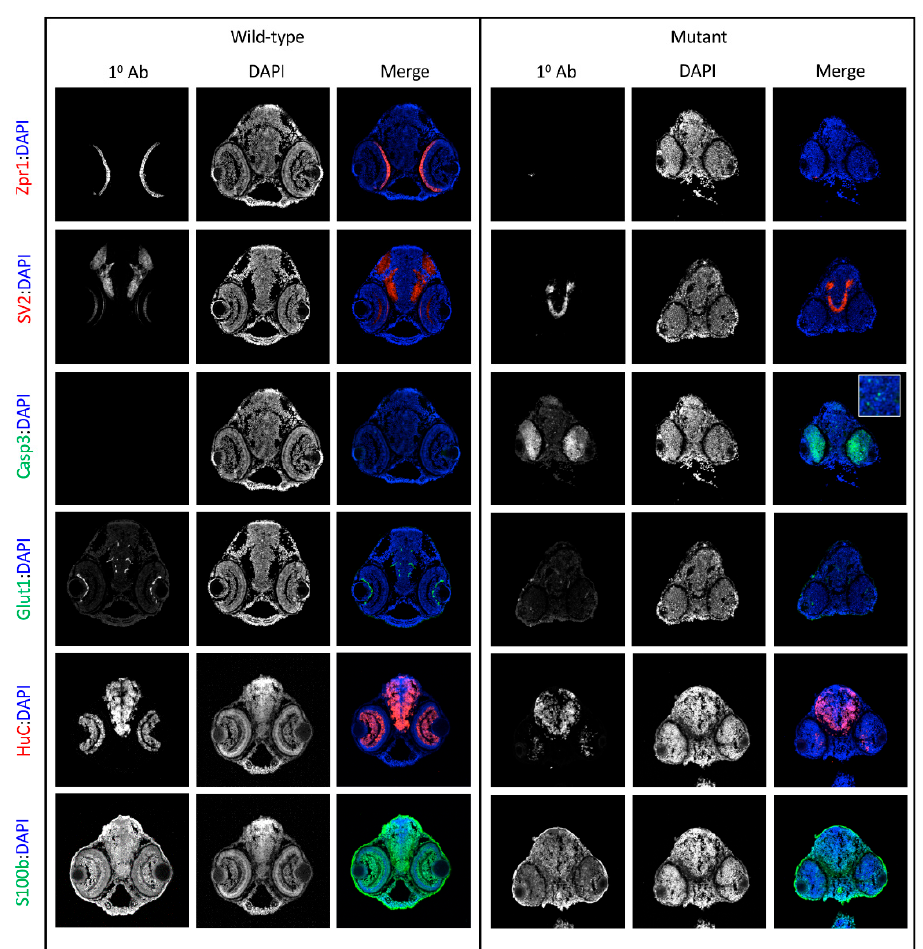
Figure 5. IHC characterizes cp27.5 mutants. IHC identifies additional abnormalities in protein expression in cp27.5 mutants at 3 dpf. All sections are counterstained with DAPI (blue) (middle columns for wild-type and mutant). Row 1 : Zpr1 (red) labels photoreceptors in the retina which are present in wildtype, but not in mutant. Row 2 : SV2 labels synaptic vesicles within the brain and within the inner plexiform layer of the retina in wild-type. SV2 is present in the brain, but absent in the retina in mutants. Row 3 : Caspase 3 is not expressed in wild-type, but is prominent in the eyes in mutants. Mutant brains also contain punctate Caspase 3 expression (inset). Row 4 : Glut1 is noticeably expressed in brain and eye vasculature in wild-type, but mutants have faint Glut1 expression in brain vasculature and eye. Row 5 : HuC is expressed in neurons throughout the brain and eye in wild-type. HuC is expressed in the brain in mutants; however, it is not as organized as wild-type and only remnants of HuC are detected in mutant eye. Row 6 : S100 β labels astrocytes in the brain and eyes in wild-type, but is greatly reduced and sporadic in the brain and eyes of mutants. Scale bars are 50 µm.